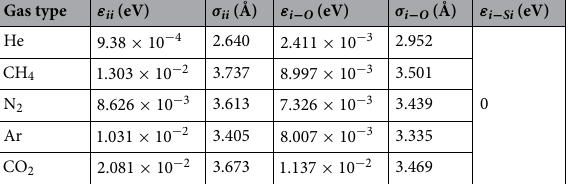
Table 3. Parameters in the 12–6 L–J potential for the gas phase. The12–6 L–J parameters for different gas species are adopted from Ref. 40 .